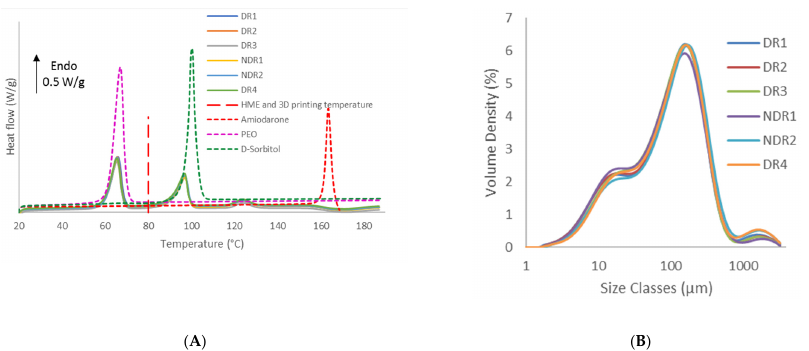
Figure 5. Differential scanning calorimeter (DSC) thermograms of amiodarone hydrochloride, polyethylene oxide (PEO), D -sorbitol and powders formulation ( A ) and particle size analysis dry dispersion method (PSD) graphs of the batches ( B ). Table 7. Summary table of powders mixtures PSD analysis.